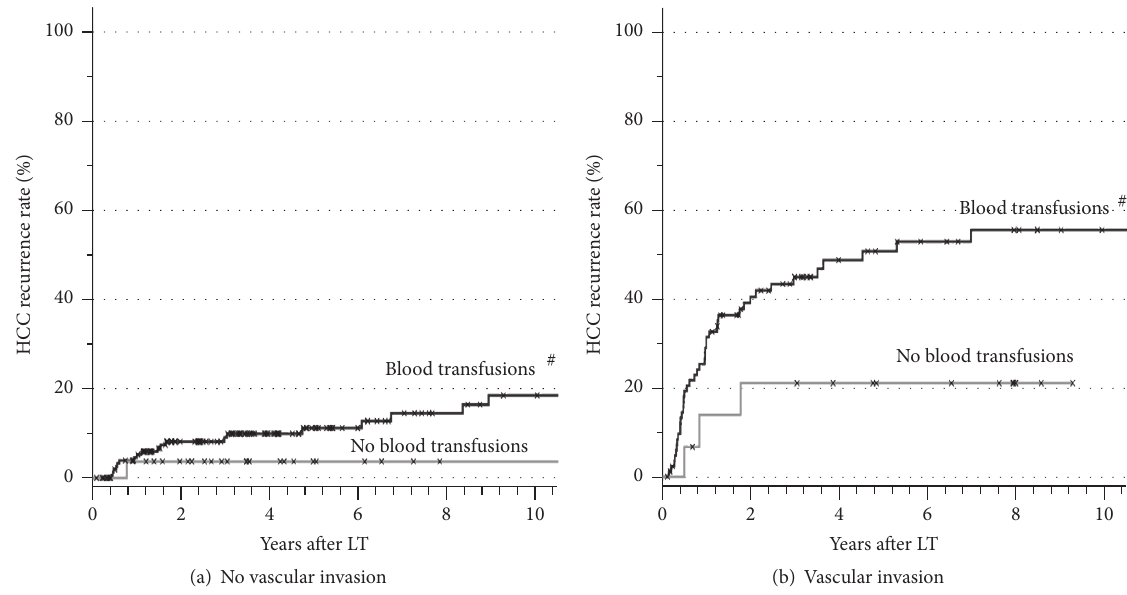
Figure 3: HCC recurrence rates in patients without (a) and with (b) microvascular invasion in correlation with application of blood transfusions intra- or postoperatively ( # 𝑝 = 0.023 for blood transfusions versus no blood transfusions tested by stratified log rank test).